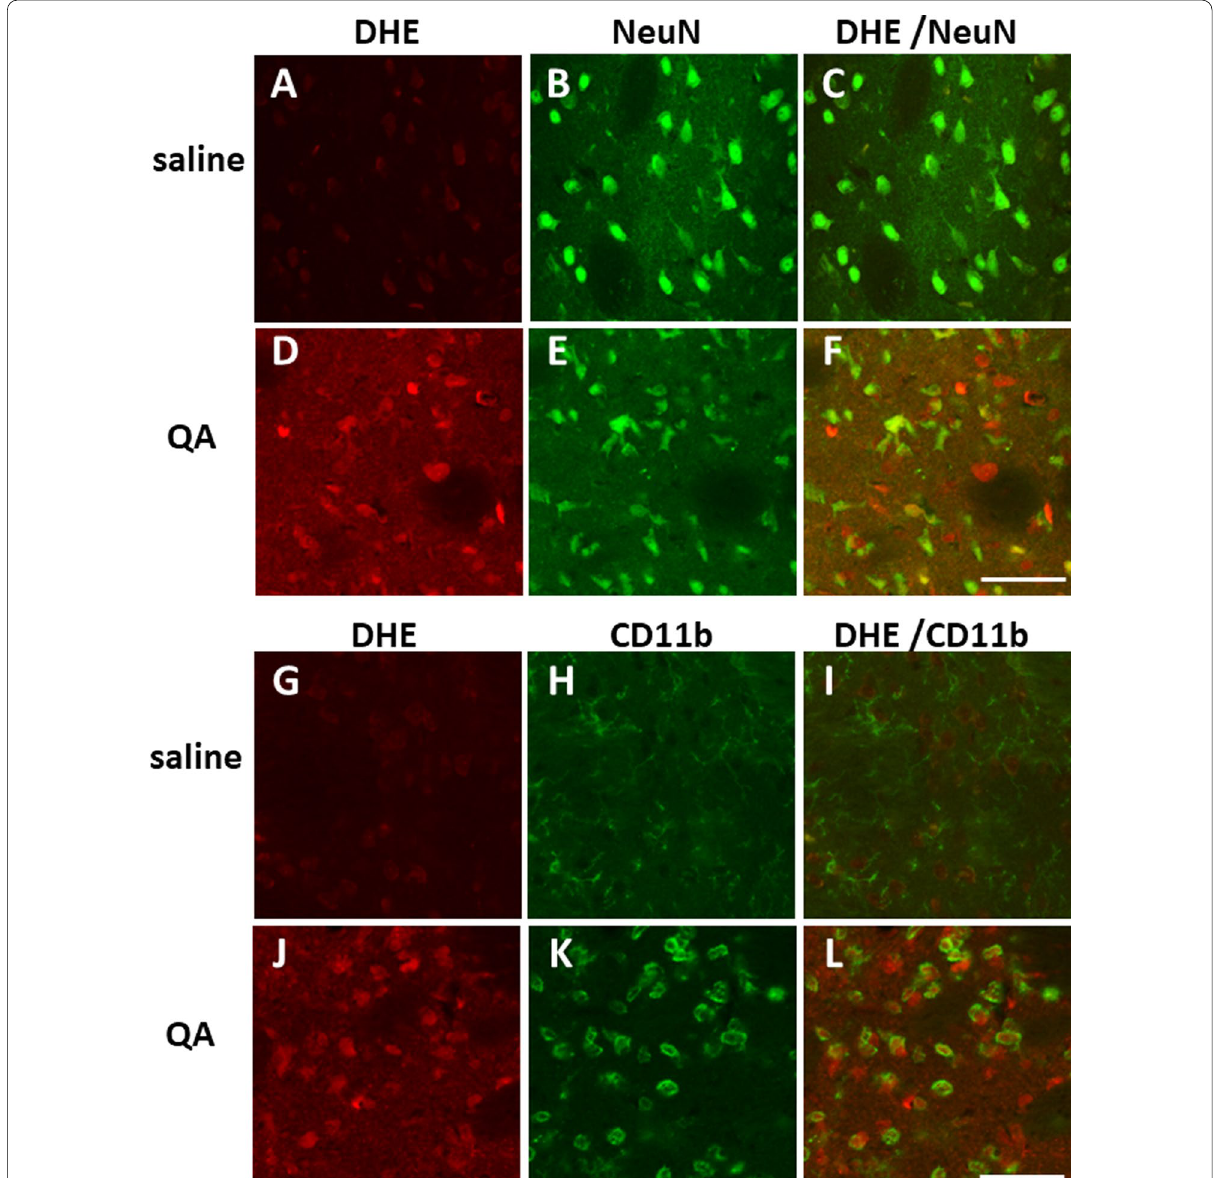
Fig. 6 Immunohistochemical analysis of NeuN- or CD11b-positive cells in the saline- or QA-injected rat striatum. Saline or QA was injected into the striatum 24 h before DHE administration. Perfusion fixation for immunohistochemical study was started 1 h after DHE administration.